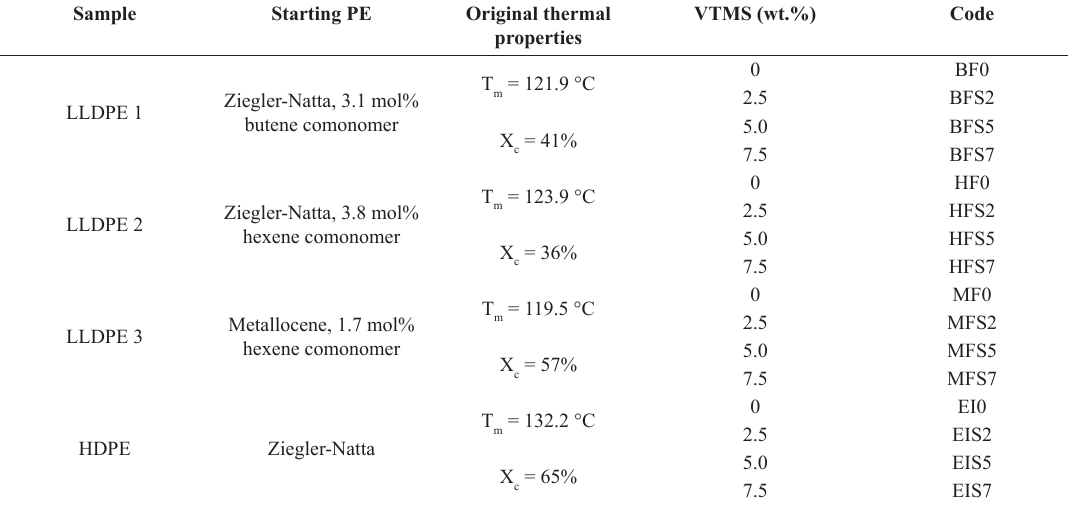
Table 1. Characteristic of polyethylenes employed and conditions of crosslinking. Sample Starting PE